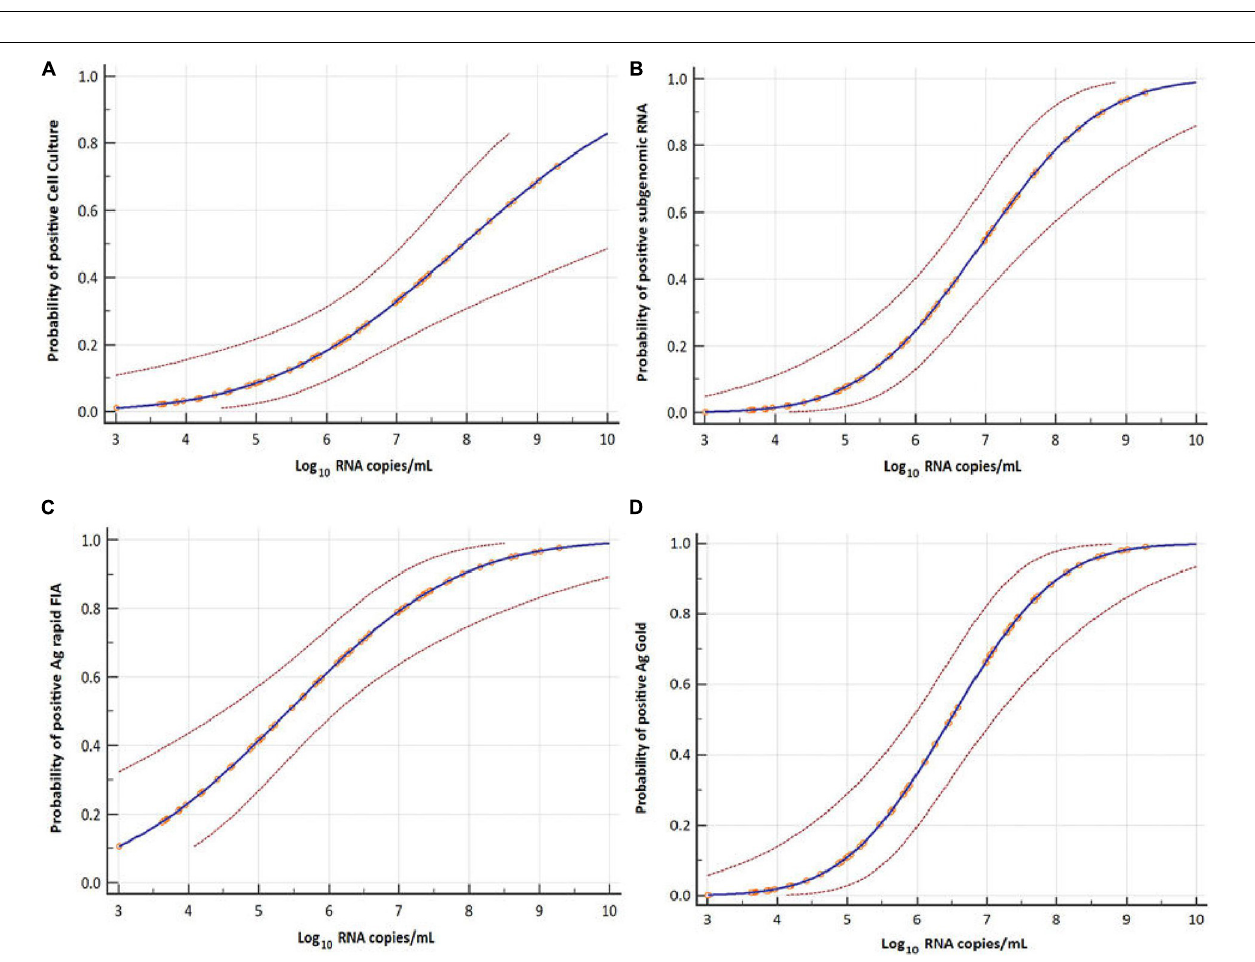
FIGURE 5 | Probit analyses for detecting infectious virus in respiratory samples. Cell culture (A) , subgenomic RNA (B), Ag rapid FIA (C) , and Ag Gold (D) with respect to viral RNA load in Log 10 copies per mL (N-gene). Blue line represents the probit curve, and dotted red lines represent the 95% confidence interval. Circles indicate marker